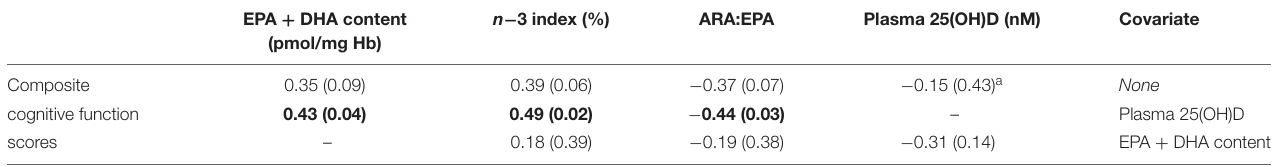
TABLE 3 | Pearson and partial correlations between composite cognitive function scores and bioavailable nutrients at week 19 ( n =